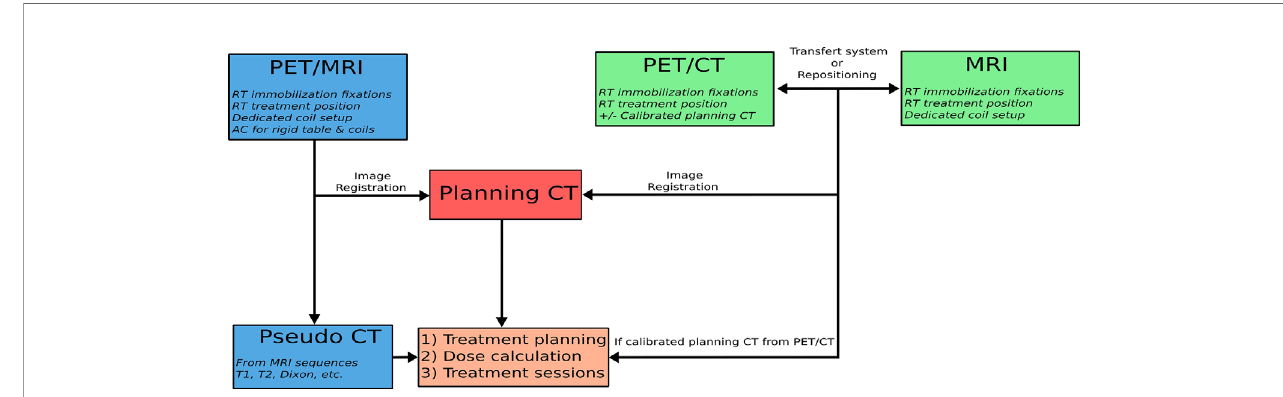
FIGURE 1 | Diagram of the process for performing the PET/CT/MRI trimodality in the radiotherapy treatment